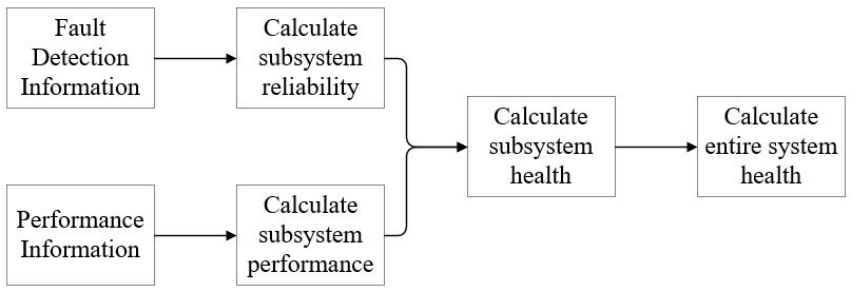
Figure 2. The calculation process of the proposed